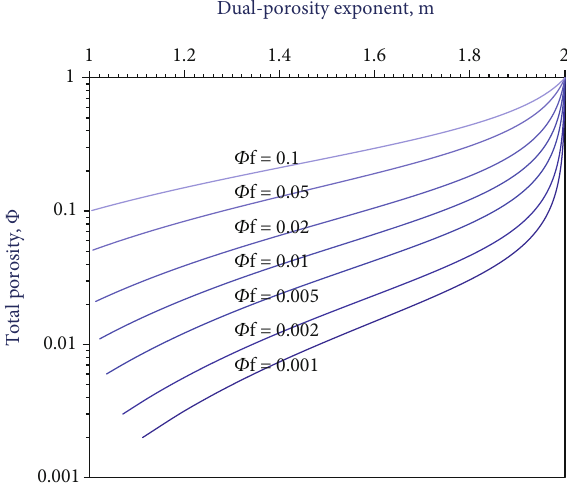
Figure 2: m determined as a function of dual-porosity media reservoirs with only matrix pores and nonconnected vugs ( m = 2 ) [6]. b